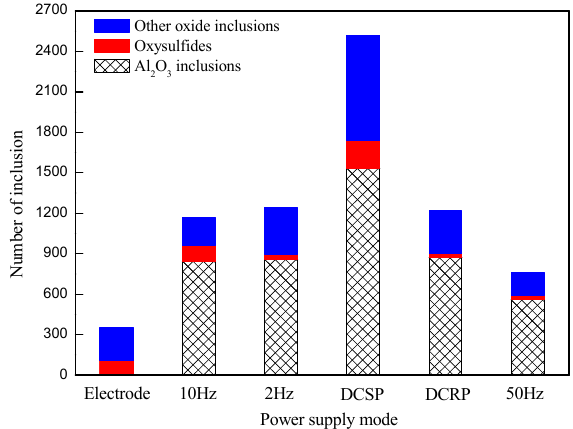
Figure 5. Effect of Power supply mode on inclusion type.